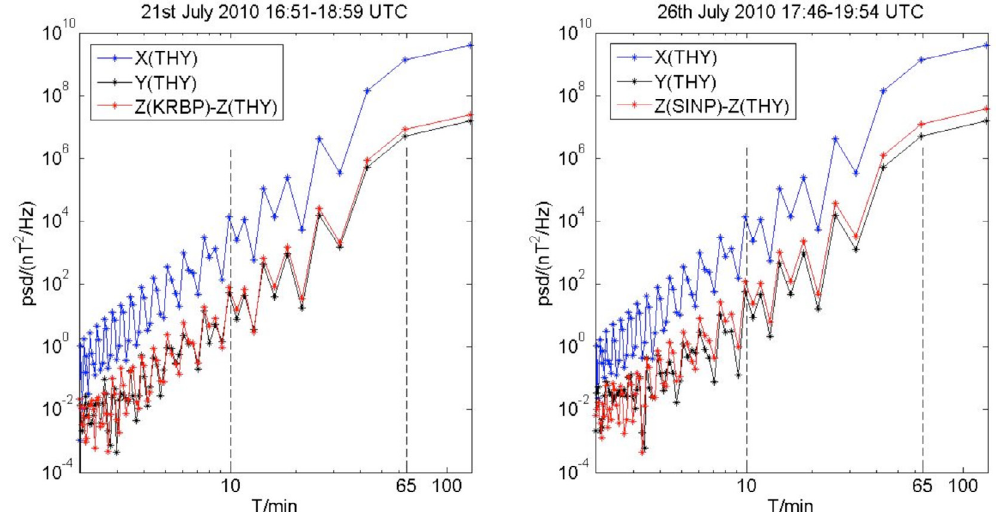
Figure 2. Left: Power spectrum density ( psd ) as a function of period ( T ), of X and Y components from THY, and of the difference of Z com- ponent at KRBP and THY, for time interval on July 21, 2010, 16:51-18:59 UTC. Right: the same as for KRBP, but for another selected time interval at SINP (July 26, 2010, 17:46-19:54